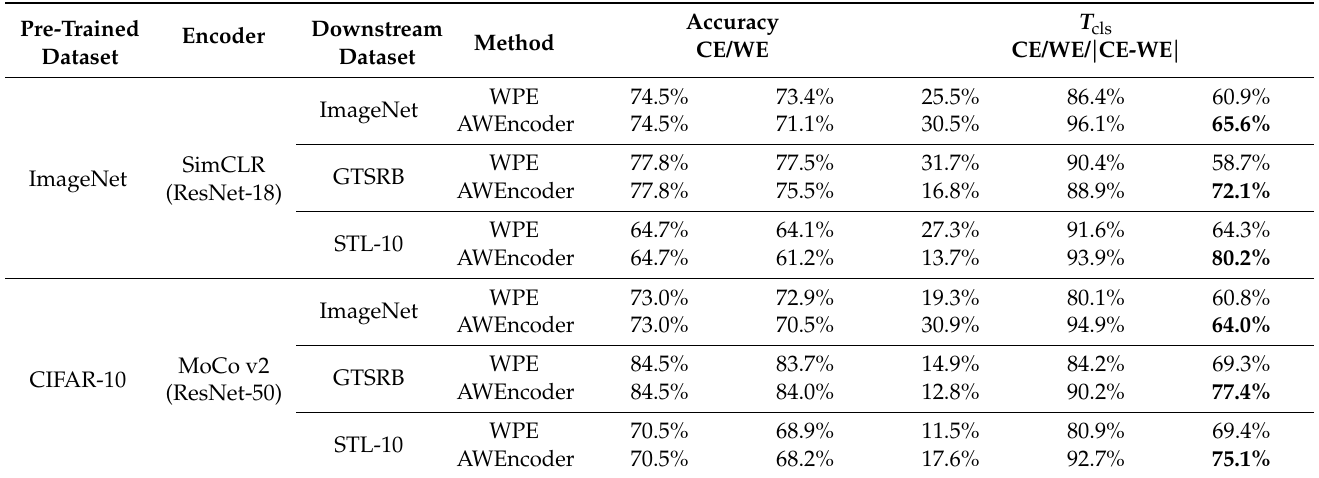
Figure 2. Some examples for the adversarial image: ( a , d , g ) are clean images randomly selected from GTSRB, ImageNet, and STL-10, respectively; ( b , e , h ) are adversarial with SimCLR; ( c , f , i ) are adversarial with MoCo v2. Table 1. Effectiveness evaluation under the black-box condition.